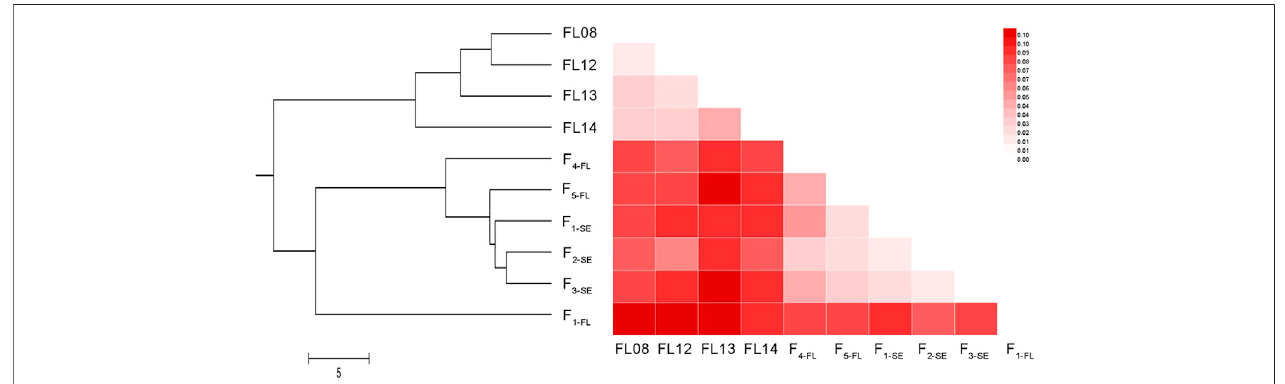
FIGURE 4 | The UPGMA phylogenetic tree and heatmap of F ST values among 10 lined seahorse collections. UPGMA clustering was based on GD among pairs of populations and the tree was built using MEGA 5.1 software.